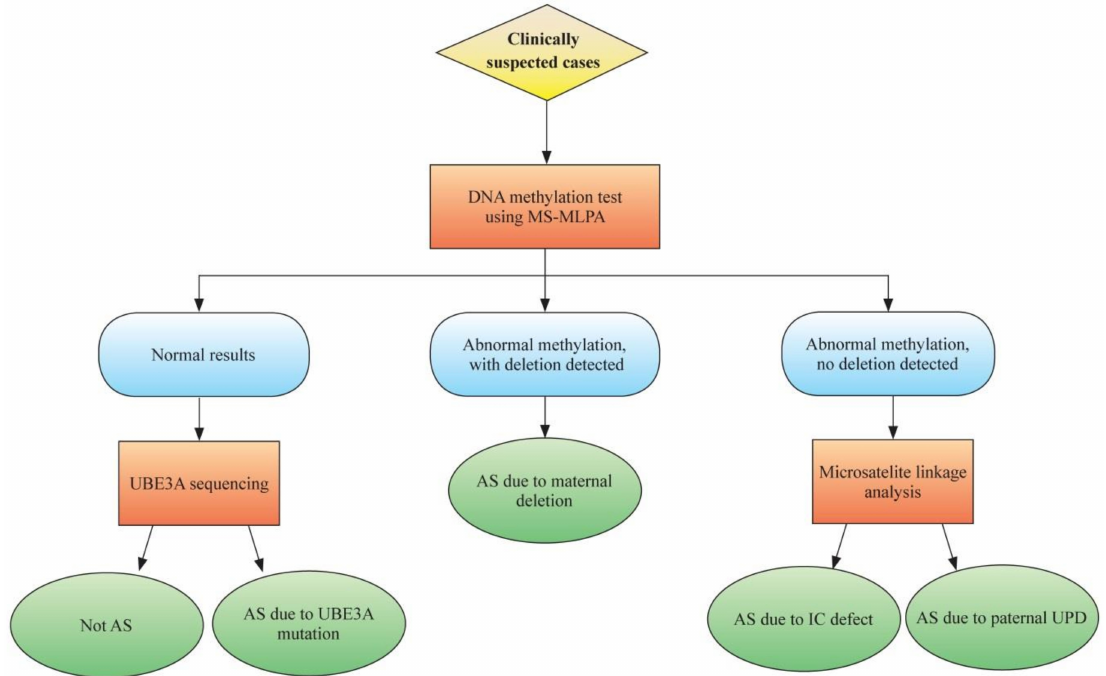
Figure 2. Molecular diagnostics for Angelman syndrome (AS). For those suspected with AS clinically, methylation analysis of the chromosome 15q11–13 region can be performed using methylation-sensitive multiplex ligation-dependent probe amplification (MS-MLPA). For those with normal methylation results, UBE3A gene sequencing is recommended to detect the UBE3A gene mutation. If UBE3A gene mutation is not detected, AS is excluded, and other diseases should be considered. For those with abnormal methylation results and deletion detected, AS due to del15q11–13 is diagnosed; for those without deletion, microsatellite linkage analysis can be done to differentiate paternal uniparental disomy (UPD) or imprinting